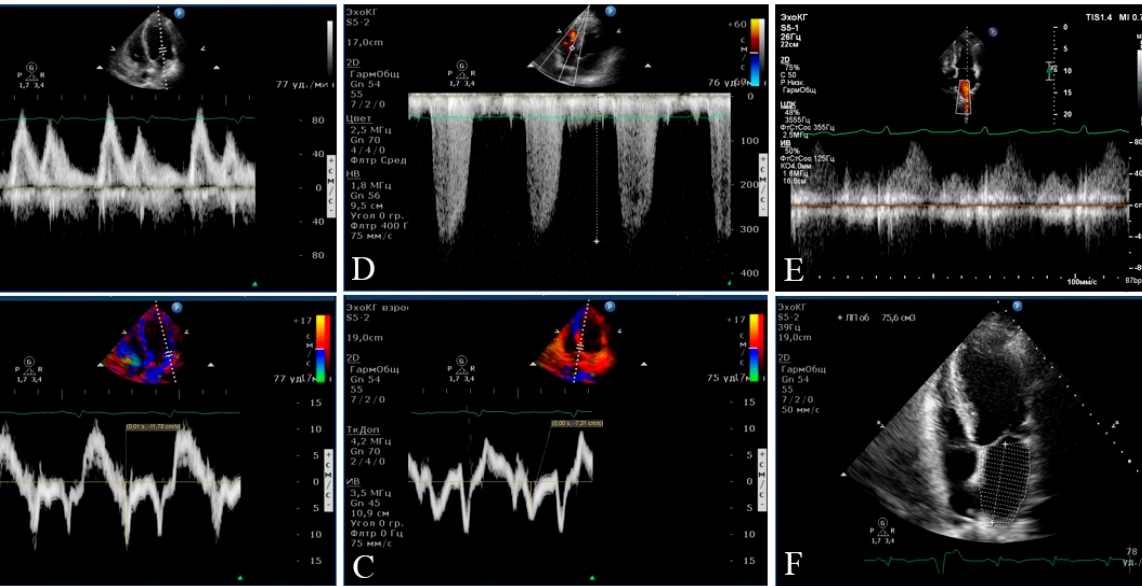
Figure 2. An episode of echocardiography in Participant B (female, 59 years old) with the 2nd stage of left ventricular diastolic dysfunction. In the Doppler mode ( A ), transmitral blood flow is shown with an assessment of Peaks E and A. In the tissue ( B , C ), the Doppler mode and the fibrous ring of the mitral valve movement are shown in the left ventricle early filling phase (Peaks e’ lateral and medial). ( D ) demonstrates the velocity of tricuspid regurgitation. ( E ) reflects the measurement of the flow in the pulmonary veins. The four-chamber position for measuring the volume of the left atrium is shown in ( F ).